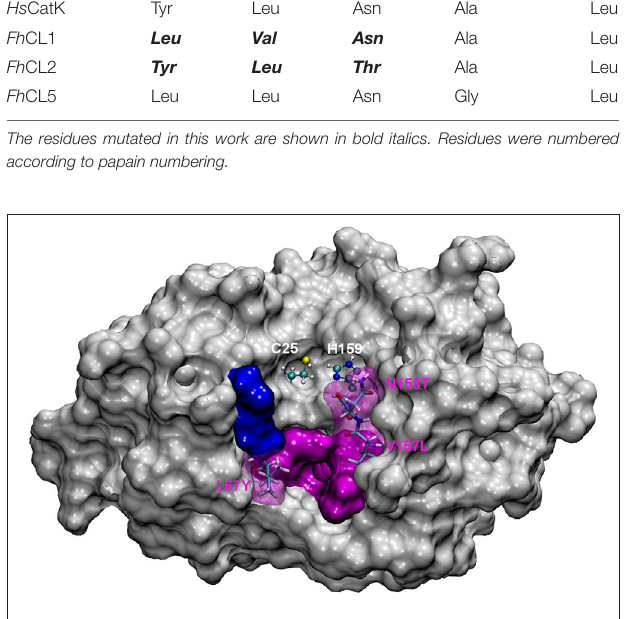
FIGURE 1 | The most representative structure for Fh CL1 is shown in gray surface, the catalytic diad Cys25 and His159 is labeled and shown in balls and sticks; pink surface represents the S 2 subsite and blue surface represents the S 3 subsite. Residues mutated in this work are represented in sticks and